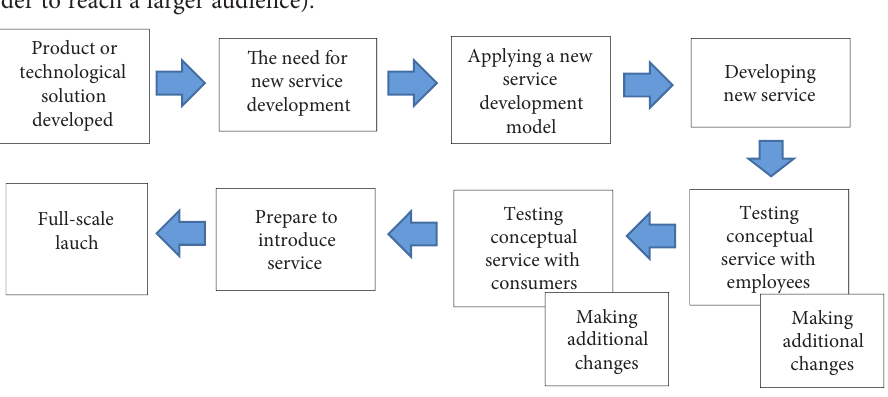
Figure 5. Possibilities of applying a NSD model after product or technological solution creation (source: compiled by the